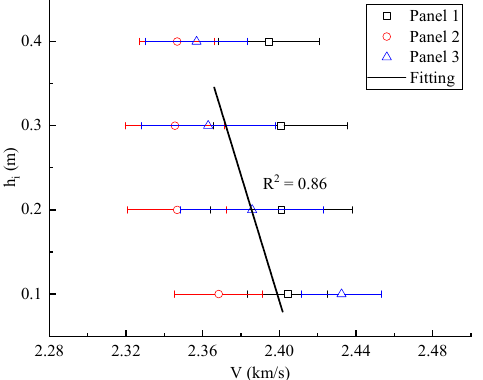
Figure 7. Variation trend of ultrasonic pulse velocity with